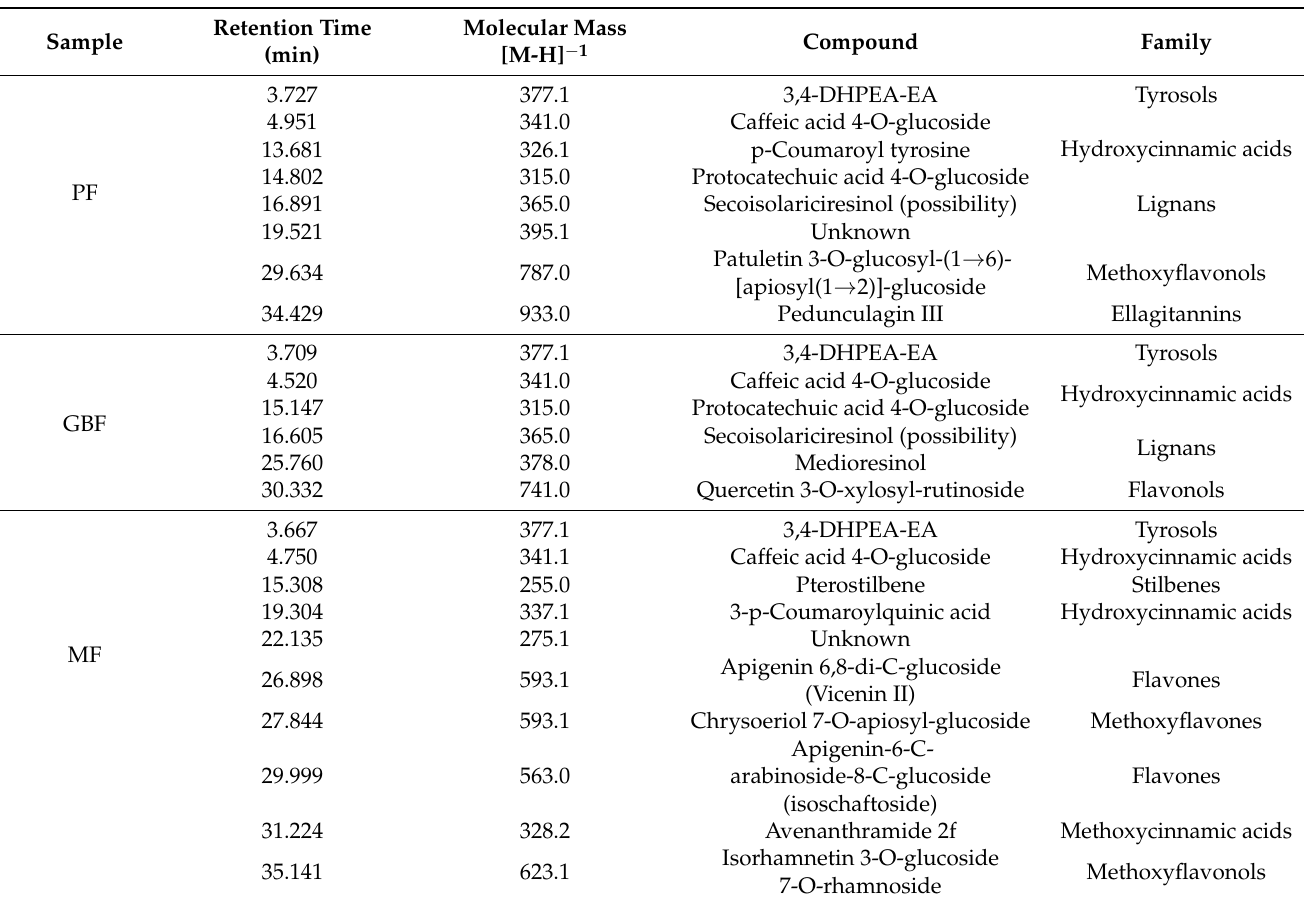
Table 3. Phenolic compounds identified in the three legumes flour